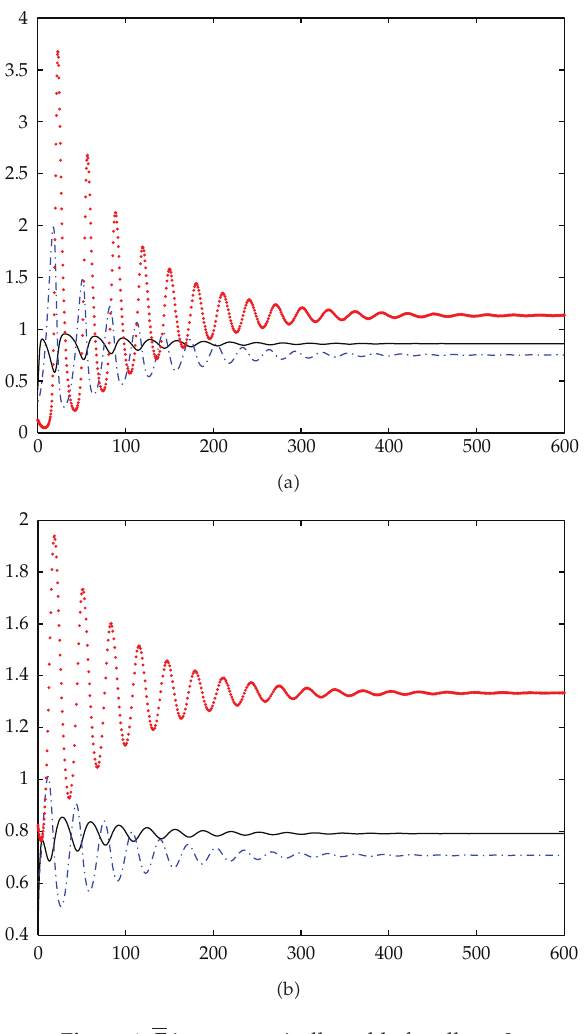
Figure 1: E is asymptotically stable for all τ >